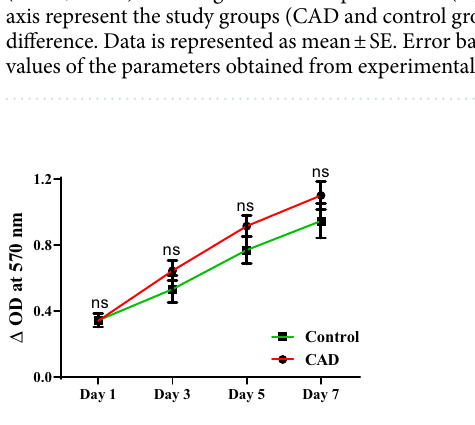
Figure 5. Cell viability assessed by MTT assay in CAD patients and controls. Mean cellular viability of ECFCs expressed in terms of change in optical density at different time points in CAD patients (n = 27) and control subjects (n = 09). Student ttest was used to assess the significance. Data is represented as mean ± SE. Error bar represent standard error of